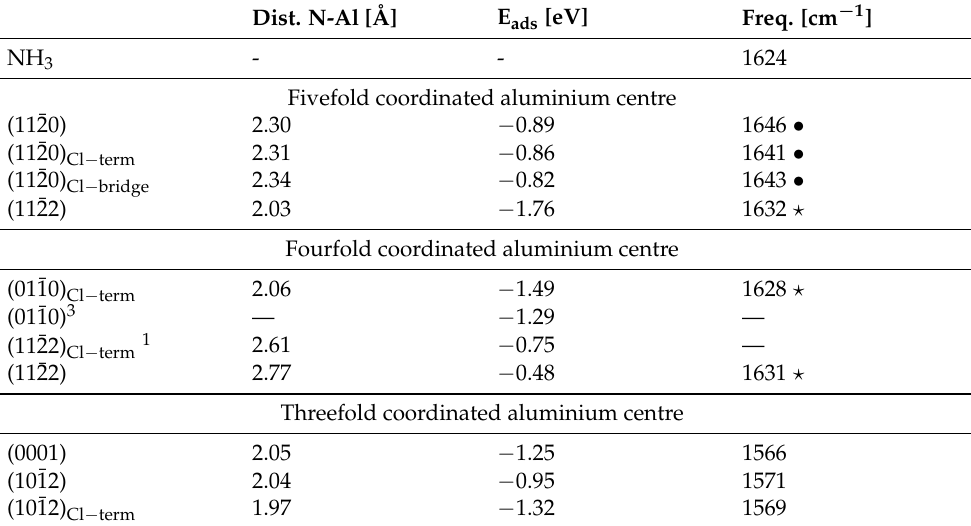
Table 3. PBE-D3(BJ) results of the adsorption properties of NH 3 bending vibration on different α -AlF 3 - surfaces and their Cl-substituted analogion’s. Experimental NH 3 bending vibration is ~1630 cm − 1